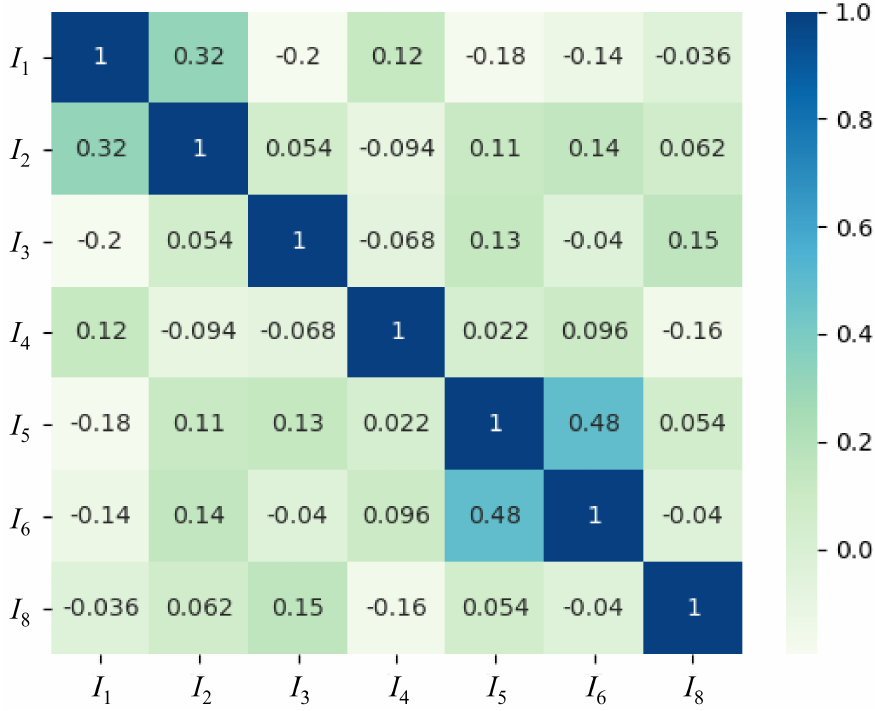
Figure 1. Heatmap of the correlation coefficient.